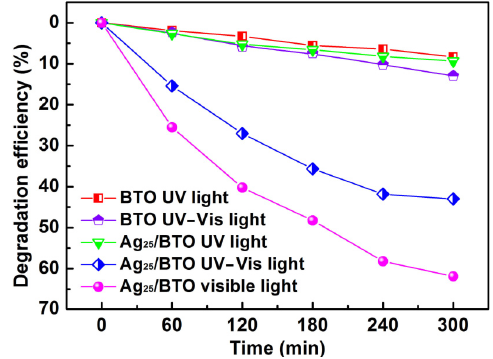
Fig. 9 Degradation rate of RhB using the Ag 25 /BTO thin film under UV, visible, and UV–Vis light, and the monolithic BTO under UV and UV–Vis light.